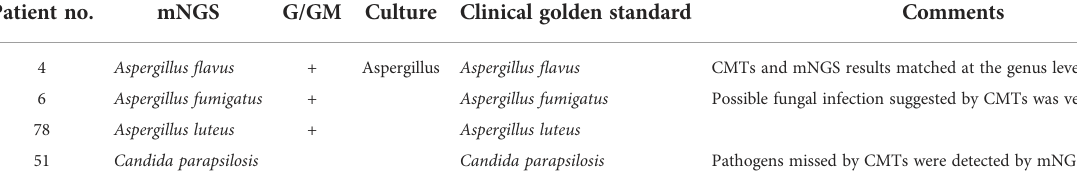
TABLE 4 Analysis of inconsistent results between mNGS and CMTs in fungi subgroup. Patient no.